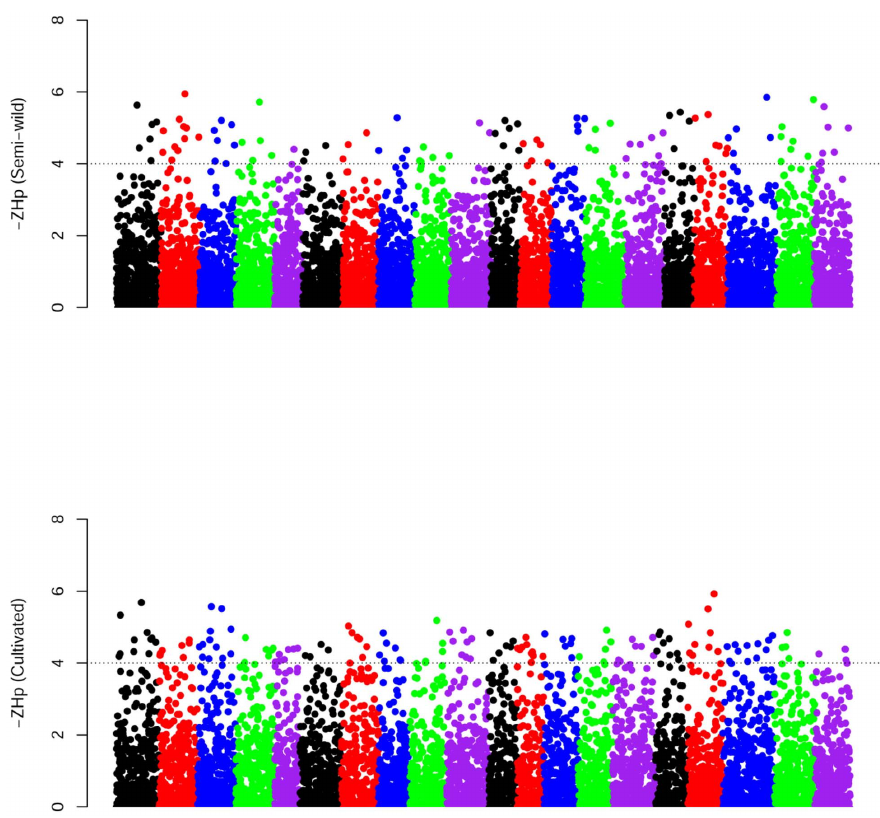
Figure 4. Summary of selective sweep analysis. Distribution of Z -transformed average pooled heterozygosity ( H p ) in semi-wild (top) and cultivated soybeans (bottom), respectively. The negative end of the Z ( H p ) distribution plotted along soybean autosomes 1–20 are shown. A dashed horizontal line indicates the cut-off ( Z , –4) used for extracting outliers.